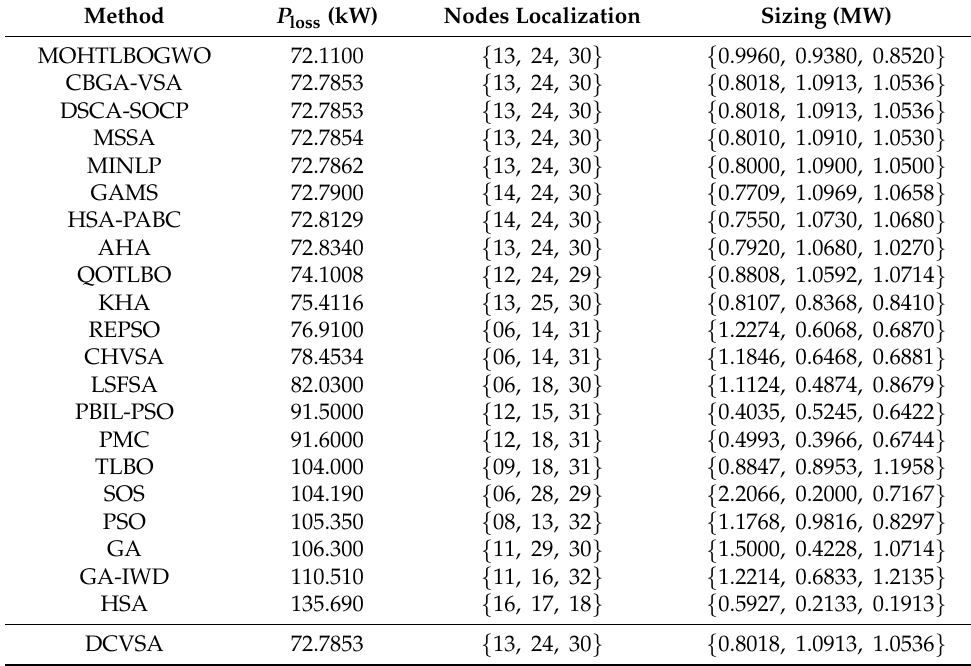
Table 3. Location and sizing of PV systems in the 33-node